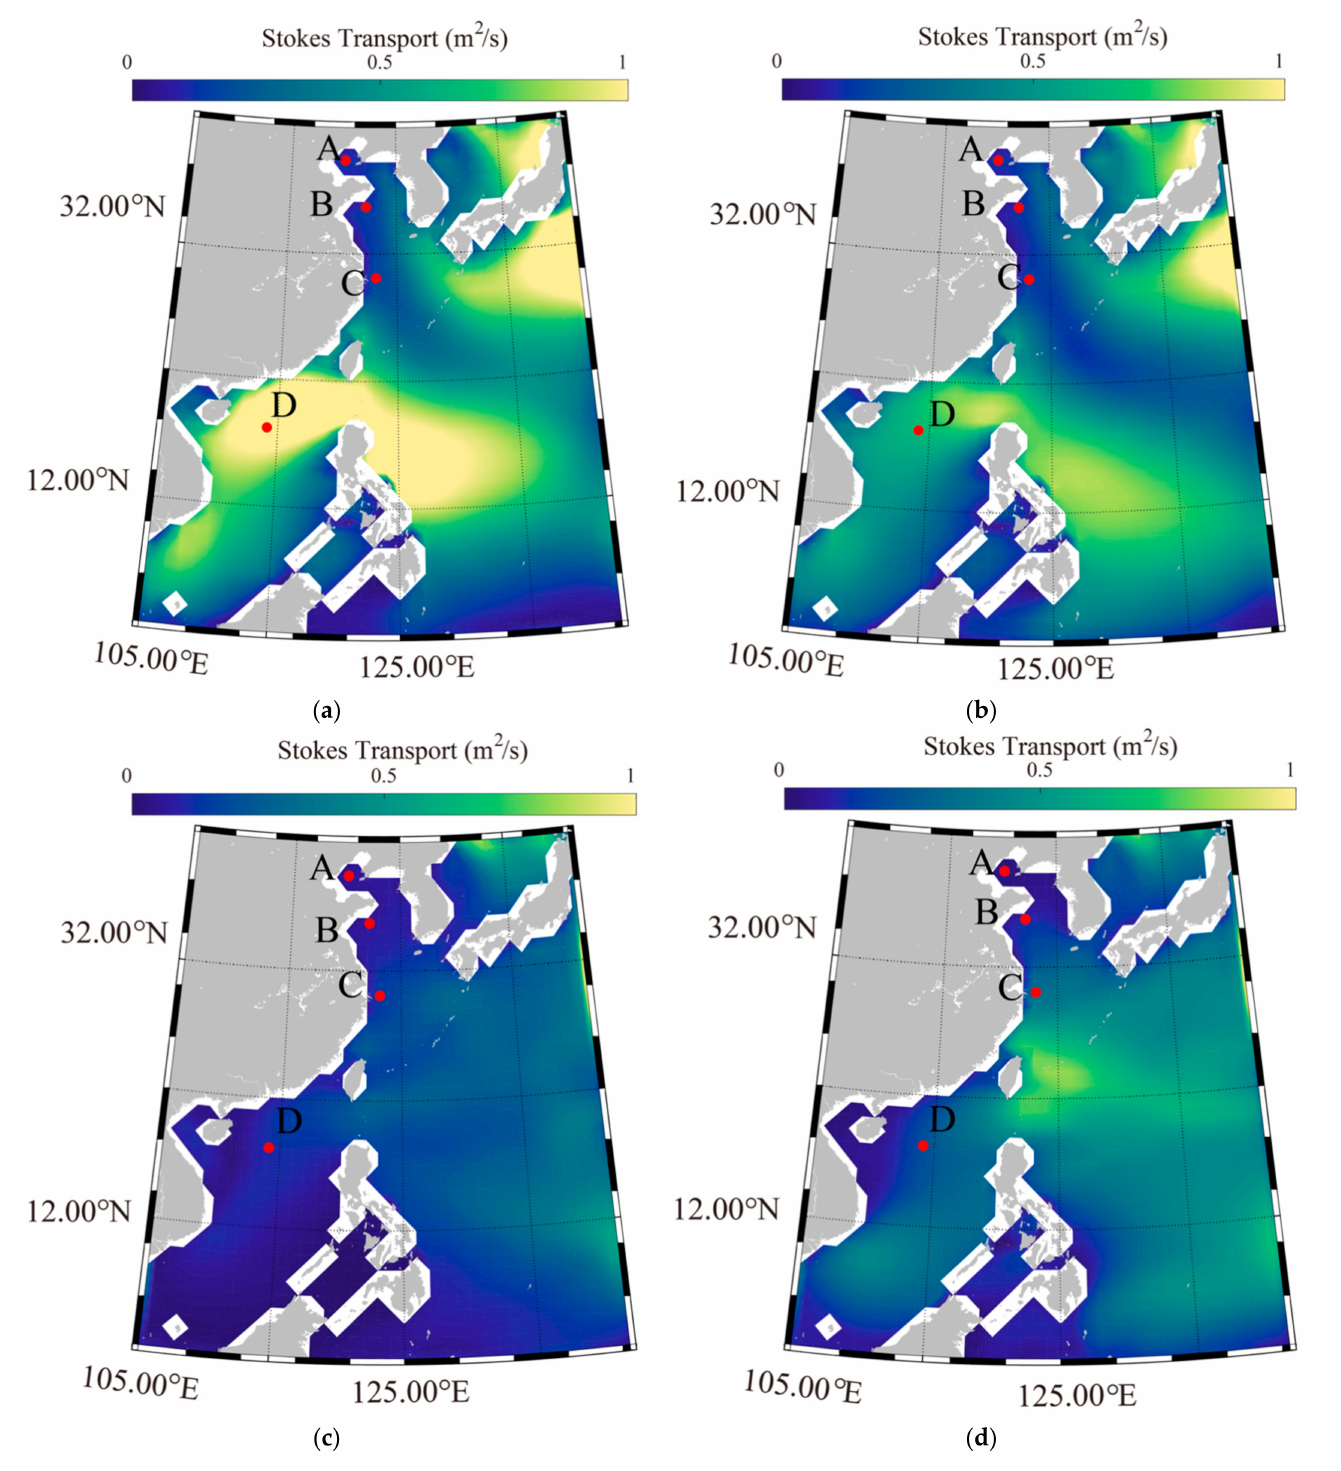
Figure 9. The monthly average of Stokes transport based on simulations from the WW3 model using CCMP wind data. ( a ) January 2015; ( b ) April 2015; ( c ) July 2015; and ( d ) December 2015. The CCMP wind data were applied for the WW3 model in 1989–2018. Interannual variation was studied at four spots in the China Sea (Figure 9). Spot A is located in the Bohai Sea, spot B in the Yellow Sea, spot C in the East China Sea, and spot D in the South China Sea. As shown in Figure 10, the Stokes transport generally increases at all spots from 0.25 m 2 /s in 1989 to 0.35 m 2 /s in 2018. However, this kind of behavior is